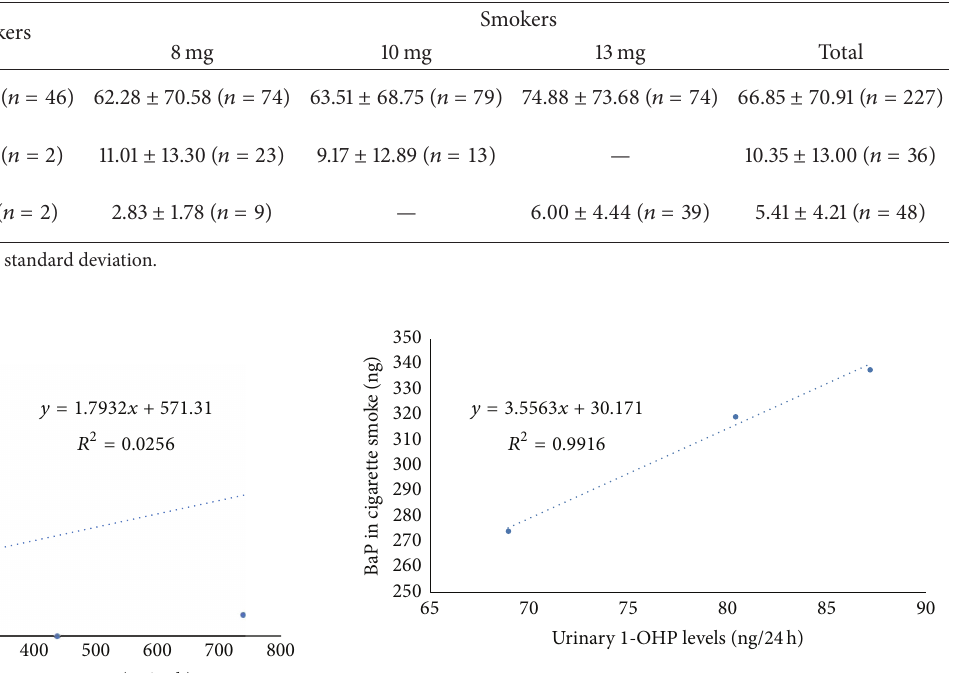
Figure 5: Correlation between urinary 1-OHP and cigarette smoke BaP under Canadian intense machine smoking